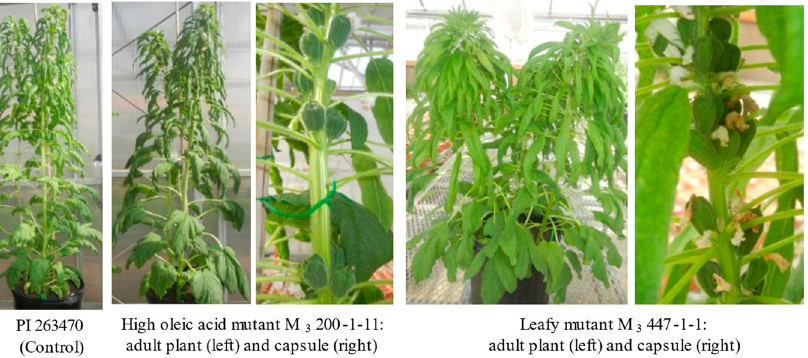
Figure 4. Comparison of plant morphology between mutant line and control.